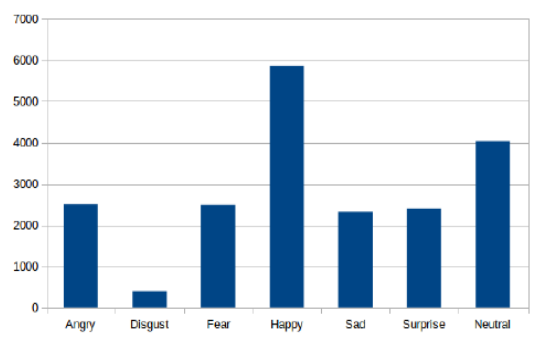
Fig. 1. FERC2013 dataset summary